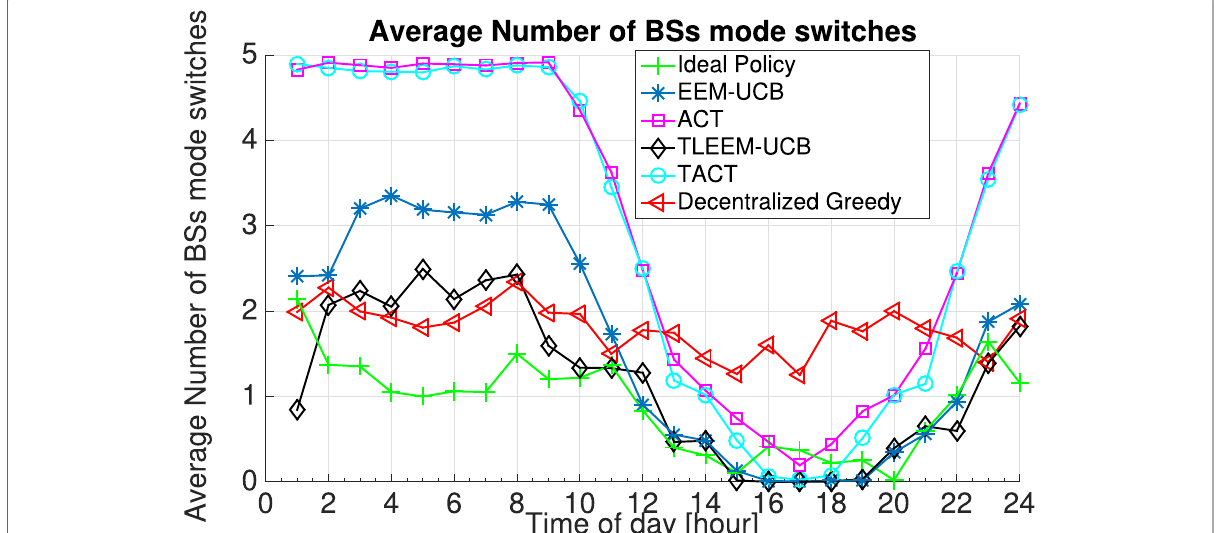
Fig. 10 Average number of BS mode switches required at each time slot during one hour with respect to time of day. The figure compares the average number of mode switches of BS each hour during 24 h for several learning